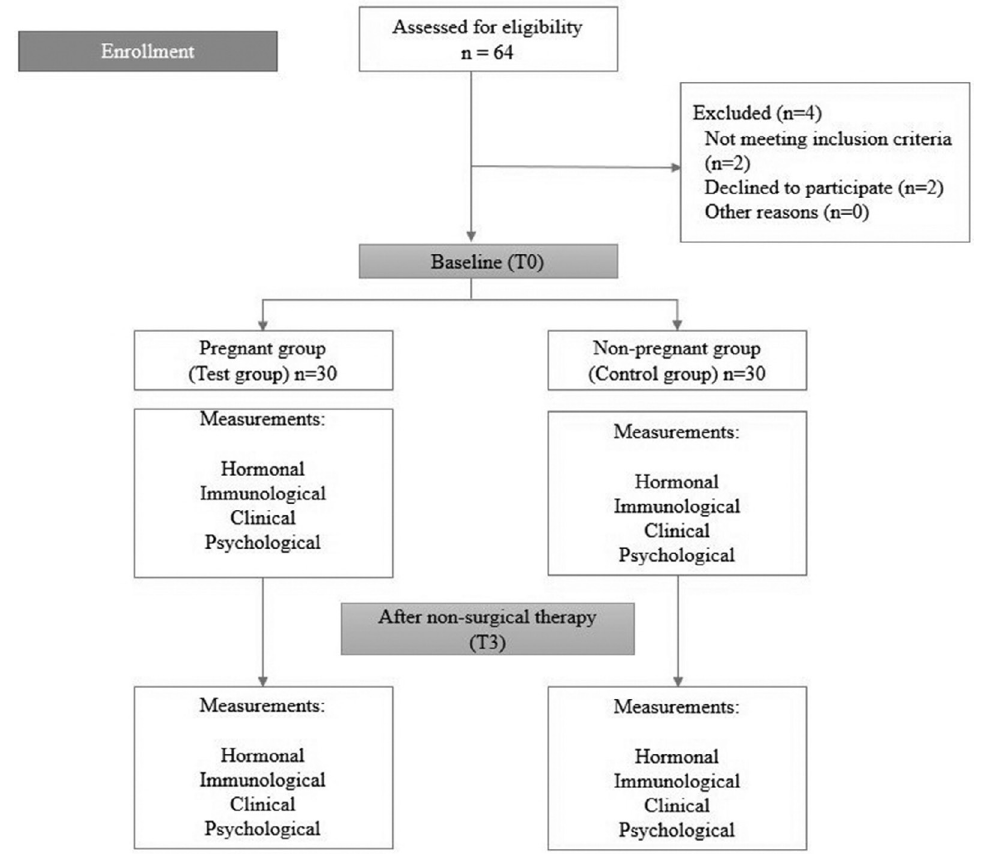
Figure 1- Follow-up flowchart of pregnant and non-pregnant